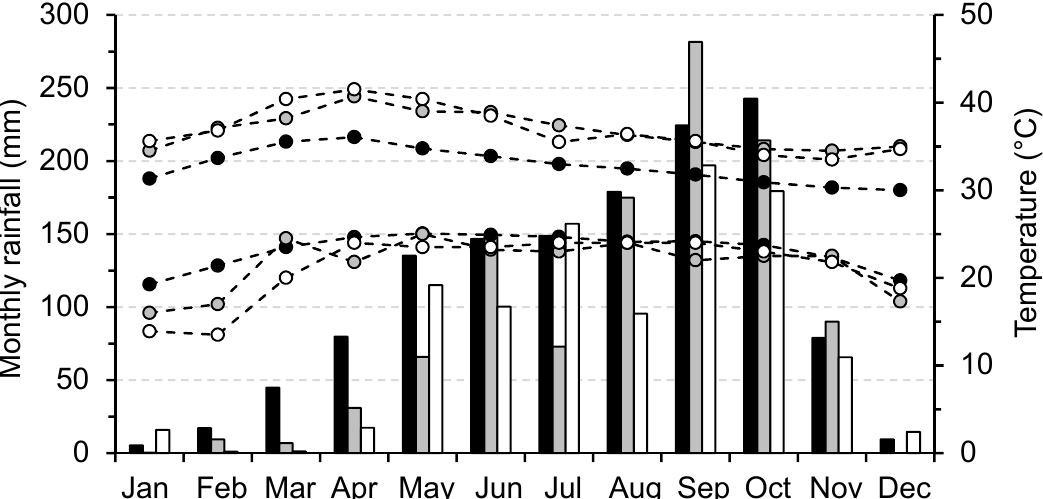
Figure 2. Monthly rainfall (bars) and average minimum and maximum temperatures (dashed-symbols) in Battambang (north-western Cambodia) in 2015 (grey) and 2016 (white) in relation to long term averages (black) for the province (1982 − 2013). All data from the Battambang Meteorological Station (13.08 ◦ N, 103.21 ◦ E).